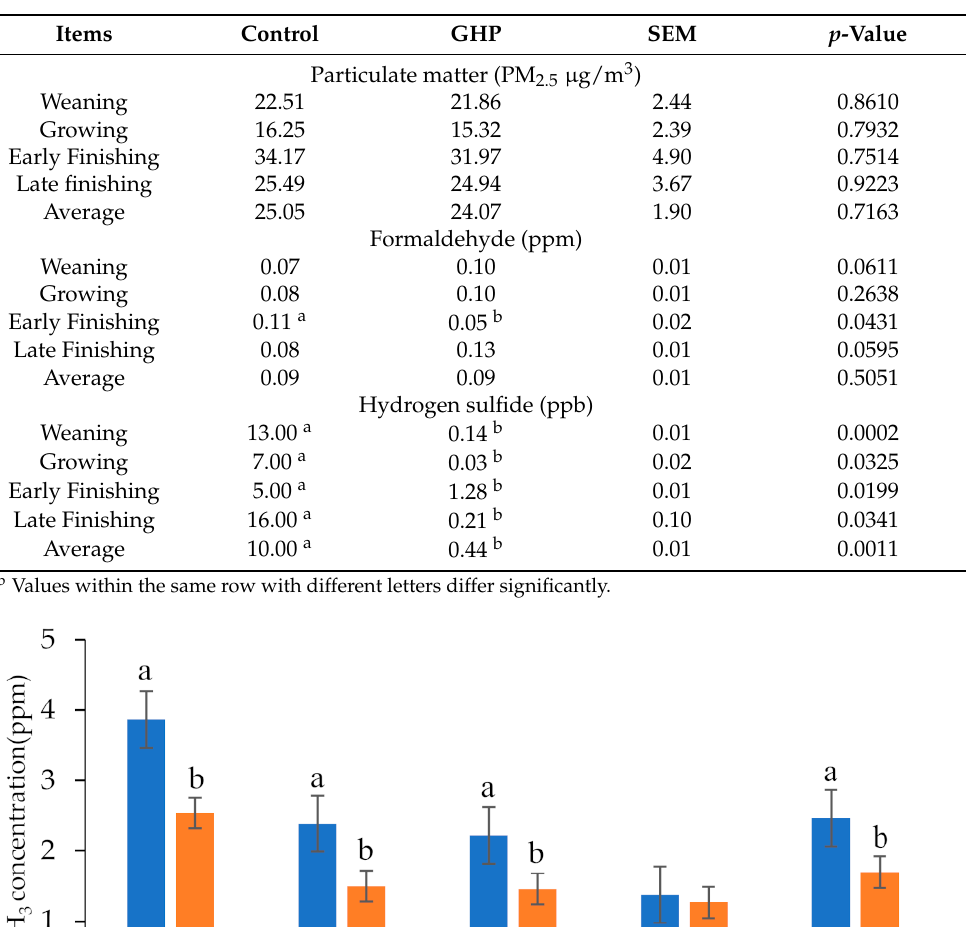
Table 4. Effect of the GHP cooling mode on the formaldehyde (ppm), PM 2.5 ( µ g/m 3 ) and hydrogen sulfide (H 2 S) (ppb) in the pig house.